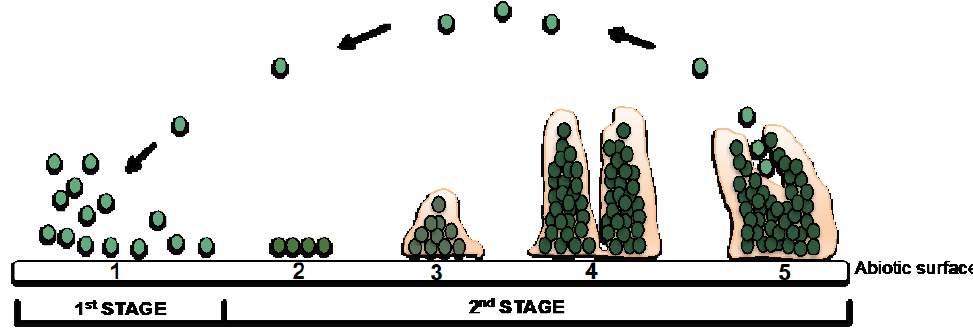
Figure 2 . Stages of biofilm formation. First stage—contact and attachment of MO to the surface; Second stage—irreversible adhesion of MO and growth; production of a biofilm and possible colonization of other areas. 1—Aggregation (reversible); 2—adhesion (irreversible); 3—microcolony formation; 4—biofilm production; 5—dispersion.